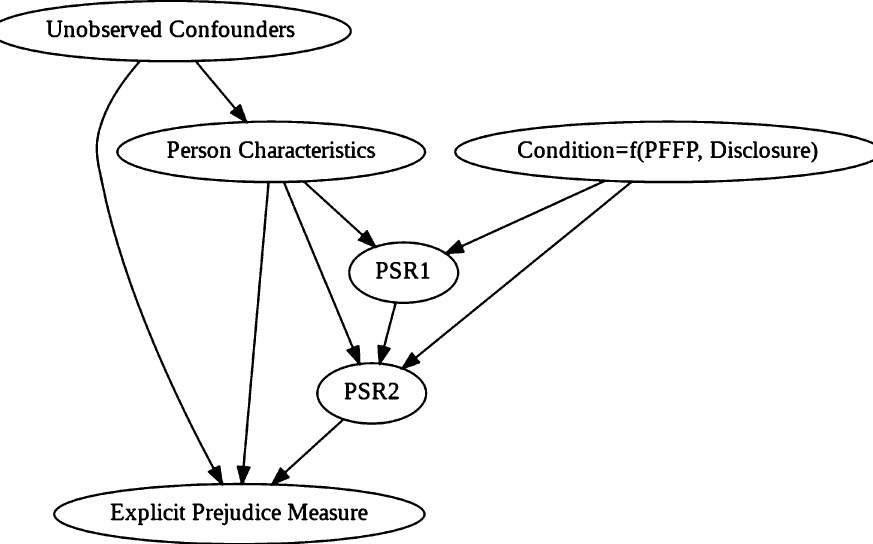
Figure 5. Causal graph for explicit prejudice measures.